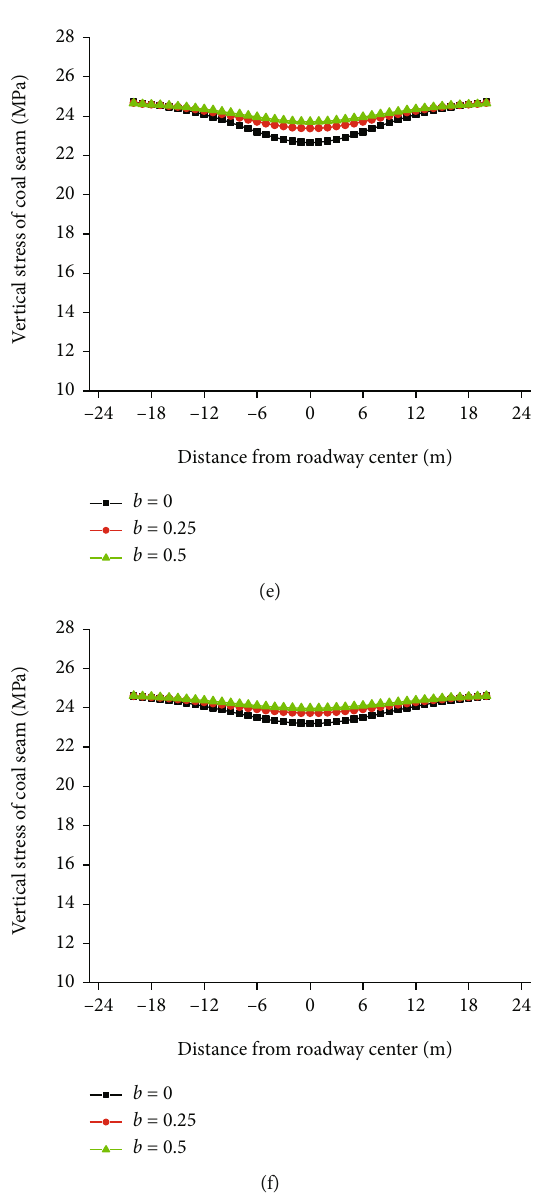
Figure 9: Vertical stress of coal seam during the excavation of fl oor roadways under di ff erent spacings.